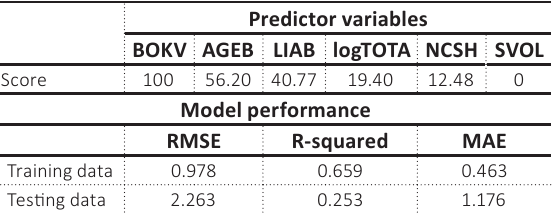
Table 4. Basic regression tree variable importance scores and performance metrics for EPS